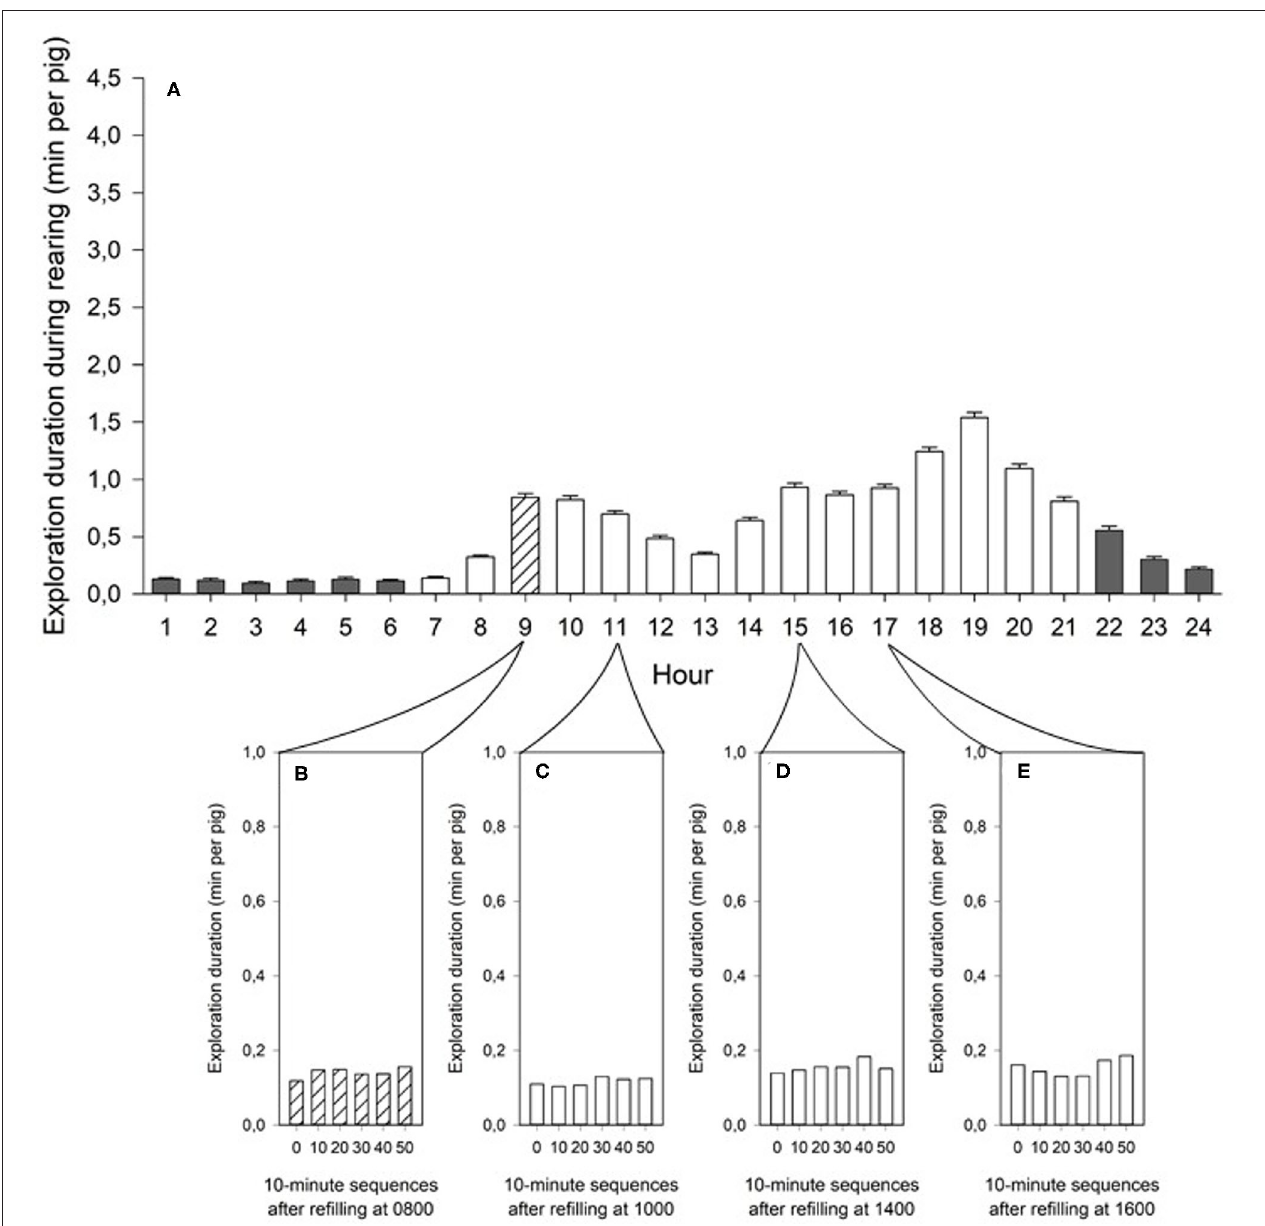
FIGURE 2 | (A) Diurnal pattern of exploration duration (mean ± SE minutes per piglet) at the dispenser filled with chopped straw in treatment R1 (one additional offer of chopped straw at 0800) during rearing. (B) Exploration durations in 10-min sequences within the hour after refilling the rooting area (striped bars). (C–E) Exploration durations within the hours at which in treatment R4 (see Figure 3 ) chopped straw was additionally offered. Light bars indicate light phase and dark bars indicate dark